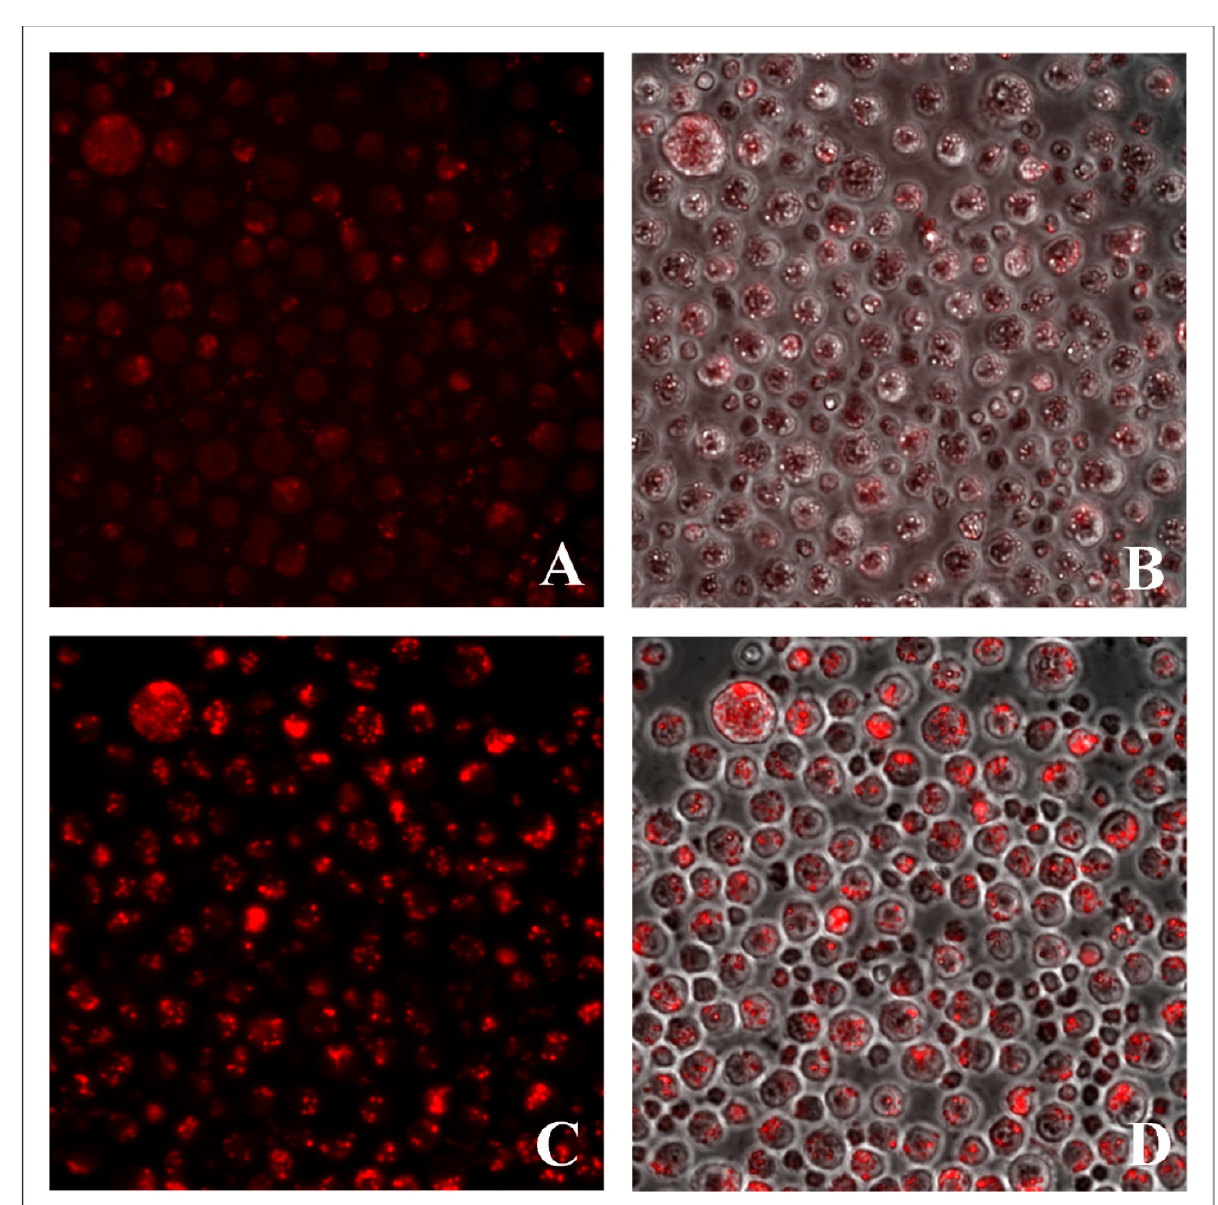
Figure 6. Ehrlich ascites carcinoma cell culture after 1.5 h ( A , B ) and 24 h ( C , D ) of incubation with